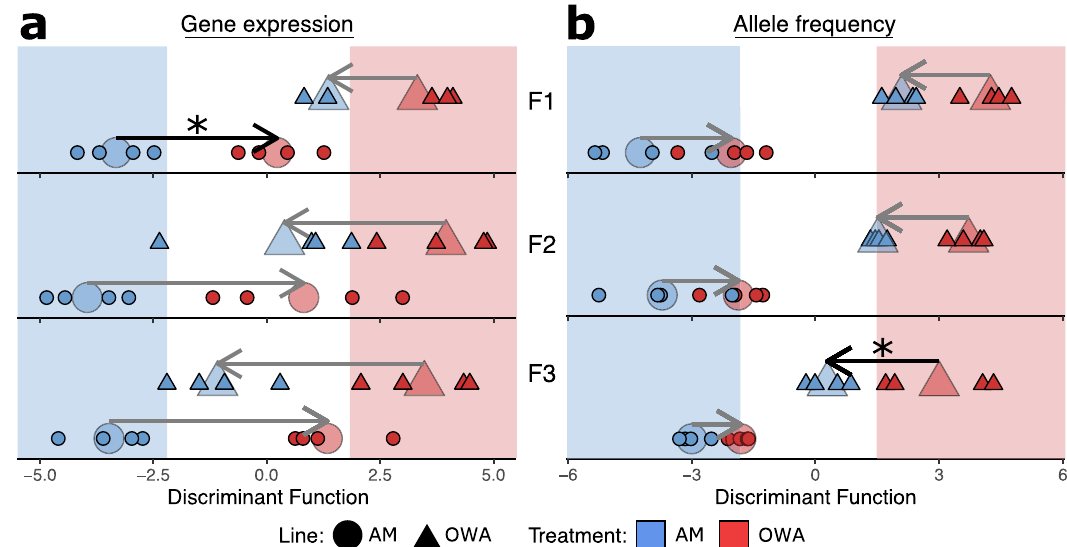
Fig. 4 Genome-wide variation in gene expression and allele frequencies across transplant generations. Discriminant analysis of principal components across three transplant generations for a gene expression and b allele frequencies. The x -axis shows the discriminant function space that maximizes differences between lines in their home environments and the background shading represents the “ home ” discriminant function space for each line. Shape and color of points indicate selection line and treatment condition, respectively. Small points are individual replicates while the mean change for each group is represented by the large transparent points; arrows connect home to transplant means. Signi fi cantly different shifts between lines are represented by black arrows and asterisks. Source data are provided as a Source Data fi